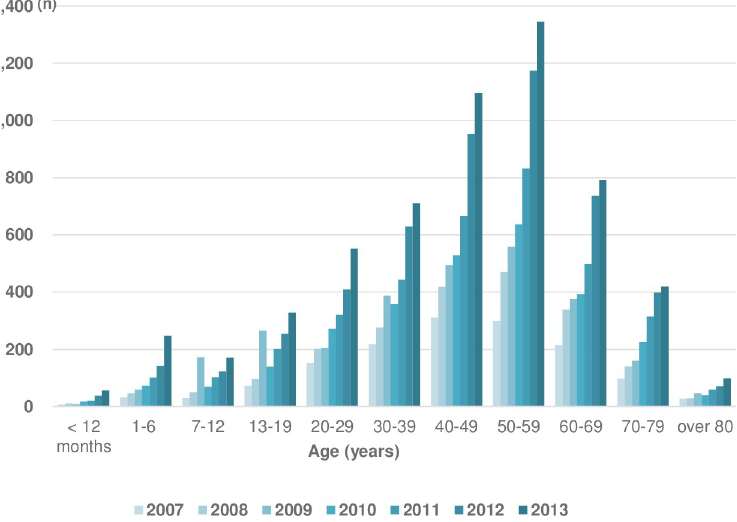
Fig 1. The emergency department visits with anaphylaxis by the age-specific group between 2007–2013 ( P < 0.001).